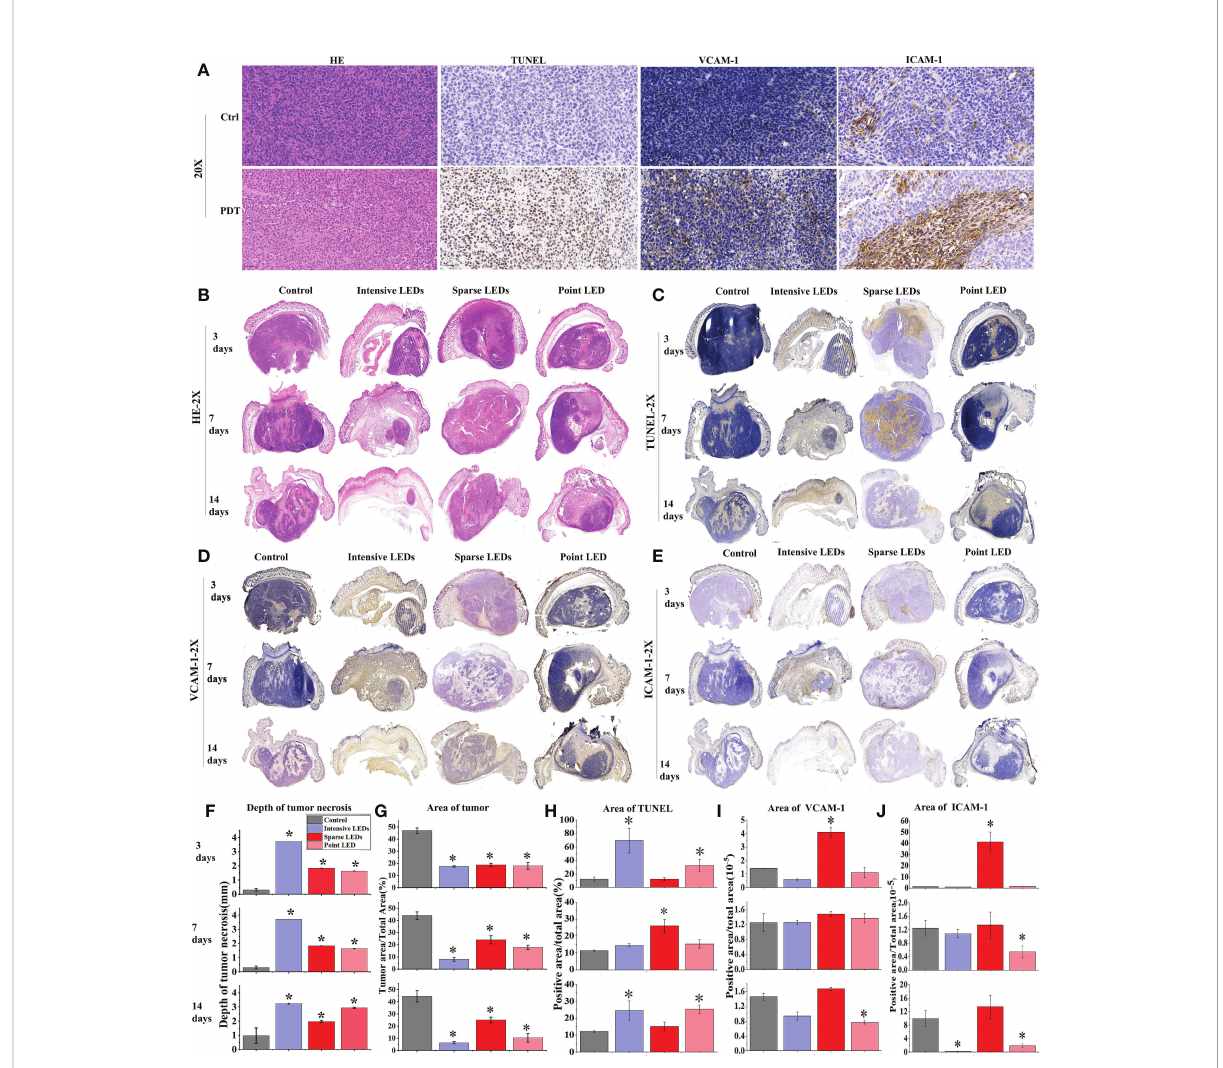
FIGURE 9 MGC-803 tumor cell necrosis, apoptosis, and angiogenesis after PDT mediated by different light fi elds. MGC-803 tumor-bearing mice were sacri fi ced on day 3, 7, and 14 after PDT. (A) Tumor tissue sections of control and intensive LED-PDT groups were stained with HE, TUNEL, VCAM-1, and ICAM-1 and then scanned with a 40× microscope, and images were magni fi ed 20×. Coronal section scans of tumor tissue stained with different indicators: (B) HE, (C) TUNEL, (D) VCAM-1, and (E) ICAM-1. Quantitative analysis of aforementioned different indicators staining results: (F) depth of tumor necrosis and (G) area of residual tumor from HE staining. (H) Area of positive cells in TUNEL staining, representing tumor apoptosis. ( I, J) Area of positive cells in VCAM-1 (I) and ICAM-1 (J) staining, positively correlated with tumor angiogenesis. (Mean ± SD, *P < 0.05 by one-way ANOVA compared with control